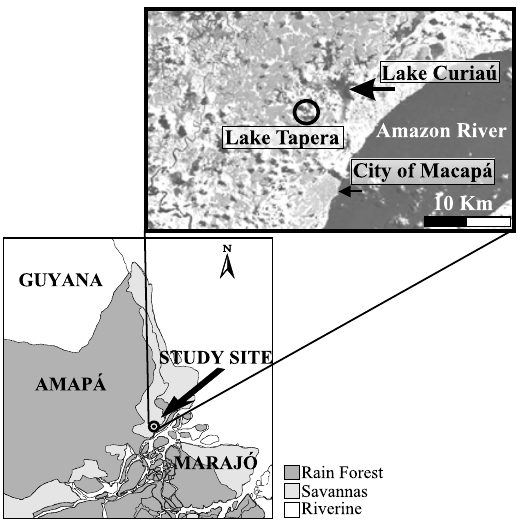
Fig. 1 – Map of the study area, showing the location of Lakes Curiaú and Tapera (the studied lake), the city of Macapá, and the Amazon